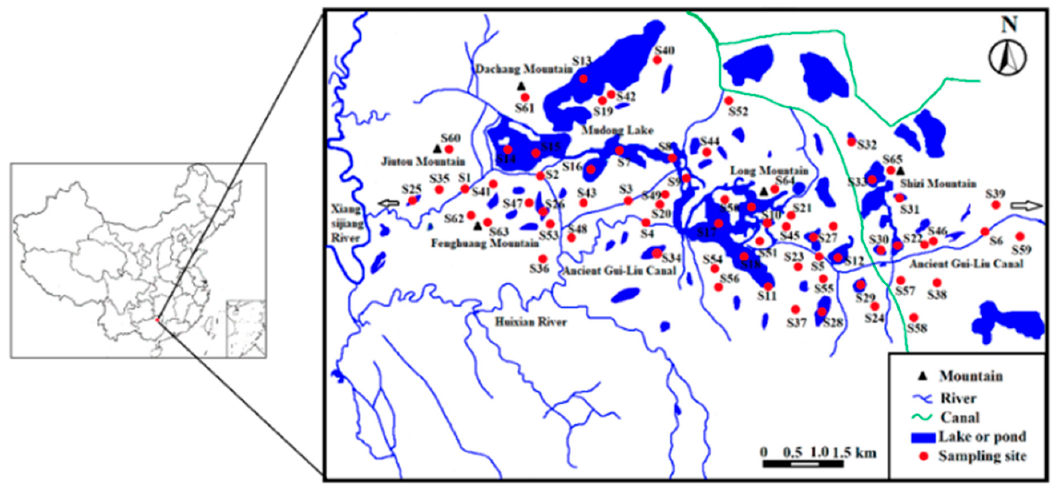
Figure 1. Sampling sites in the Huixian wetland.